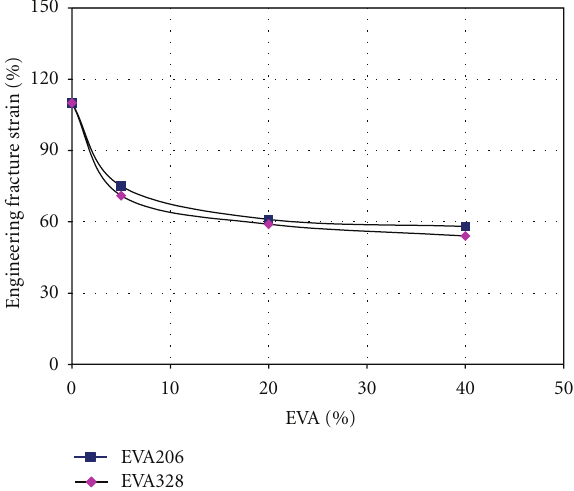
Figure 13: Variation of HDPE/EVA blends strain at fracture with EVA contents and